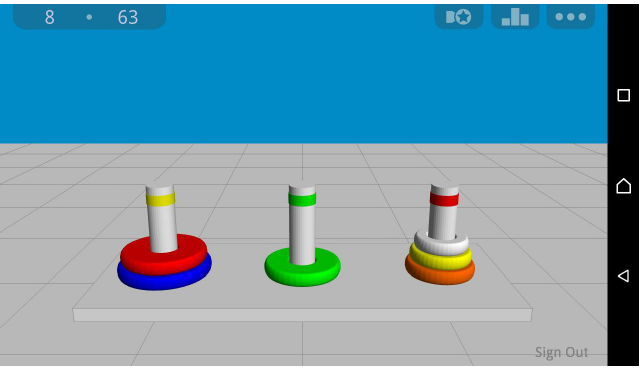
Figure 1. Digital version of the Tower of Hanoi problem with five disks, named TOH5.